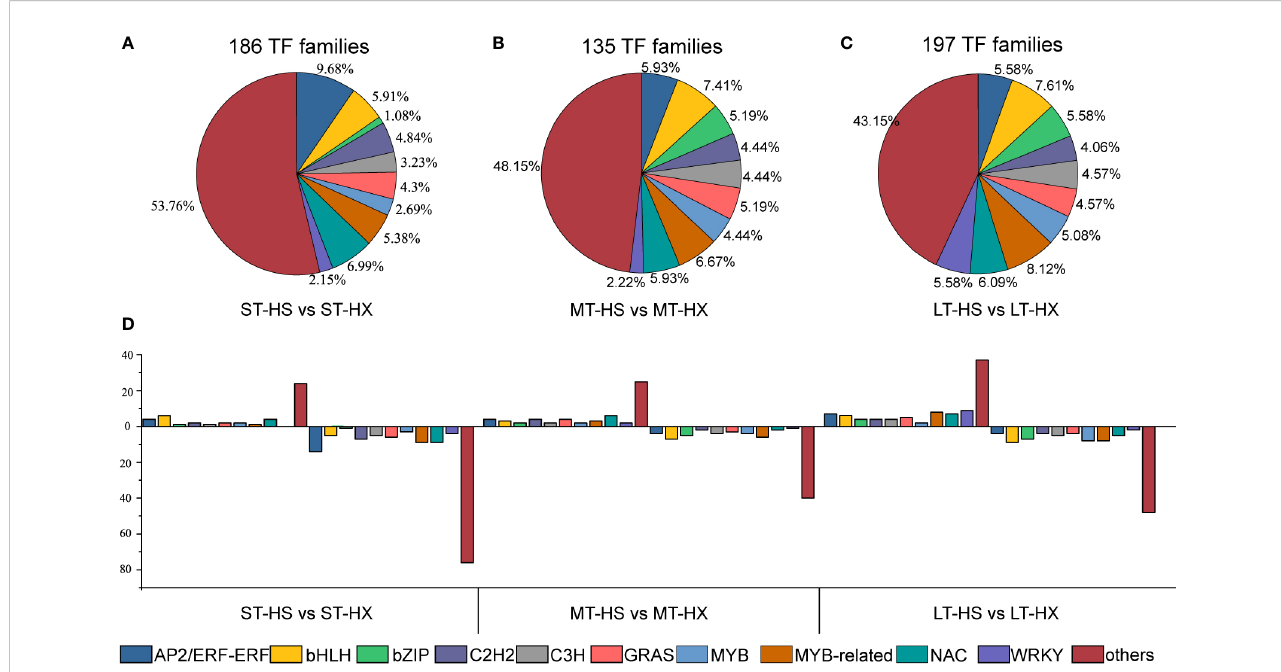
FIGURE 4 Cold stress-responsive TFs. (A – C) Distribution of TF families under ST, MT, and LT cold stress, and (D) up- and down regulated TF families.